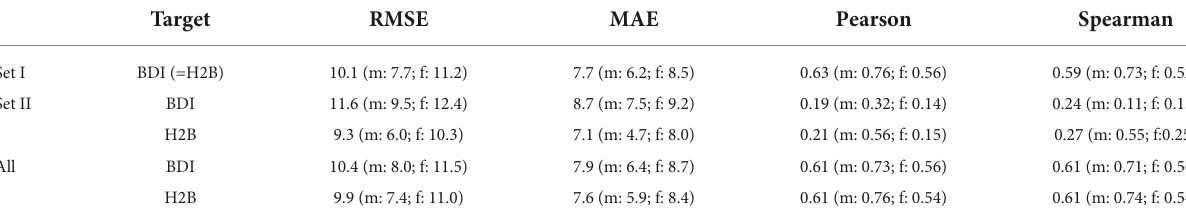
TABLE 3 Accuracy of depression prediction, when the BDI scores were used for